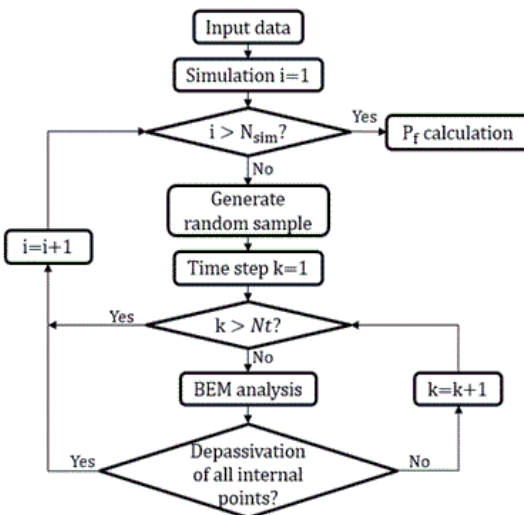
Figure 3 – Flowchart of the proposed numerical approach